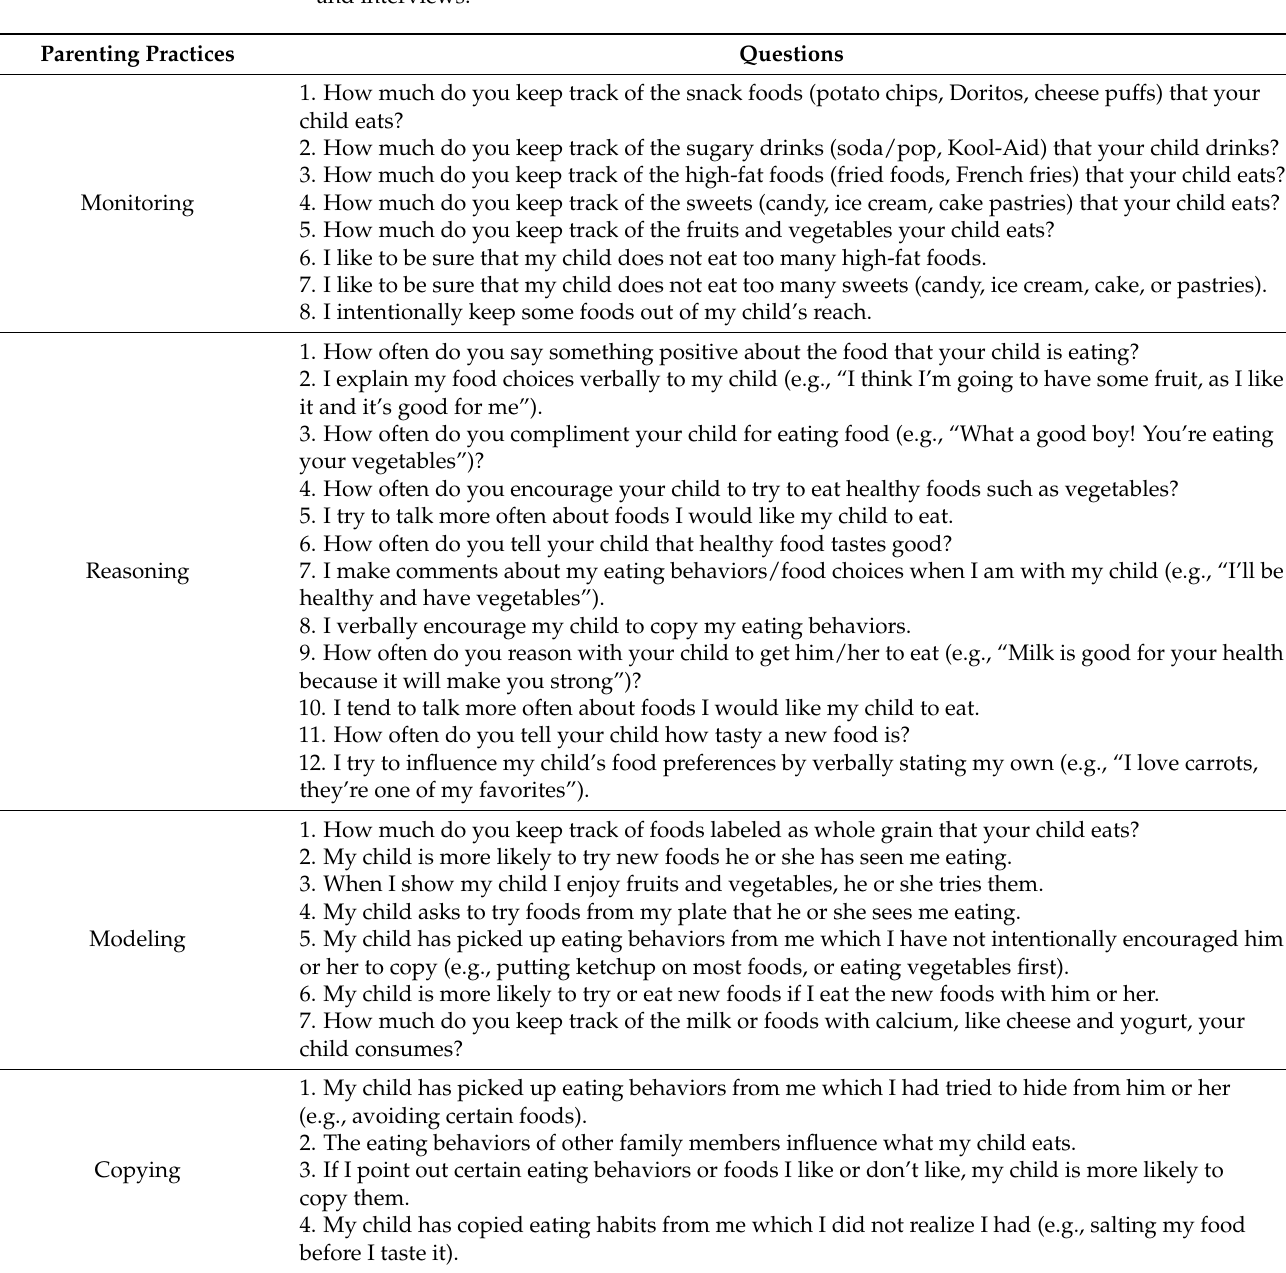
Table 2. The items of the parental survey to identify parenting practices as obtained from the CGPQ and